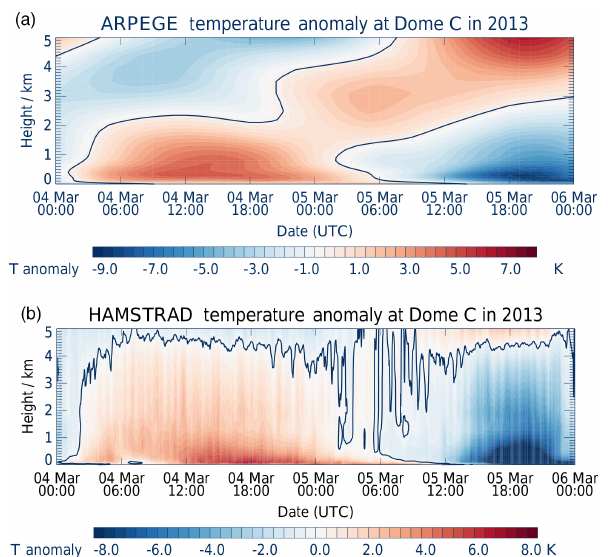
Figure 11. Temperature anomaly from 4 to 5 March 2013 above the Dome C station as calculated by the ARPEGE model (a) and as measured by the HAMSTRAD radiometer (b) .